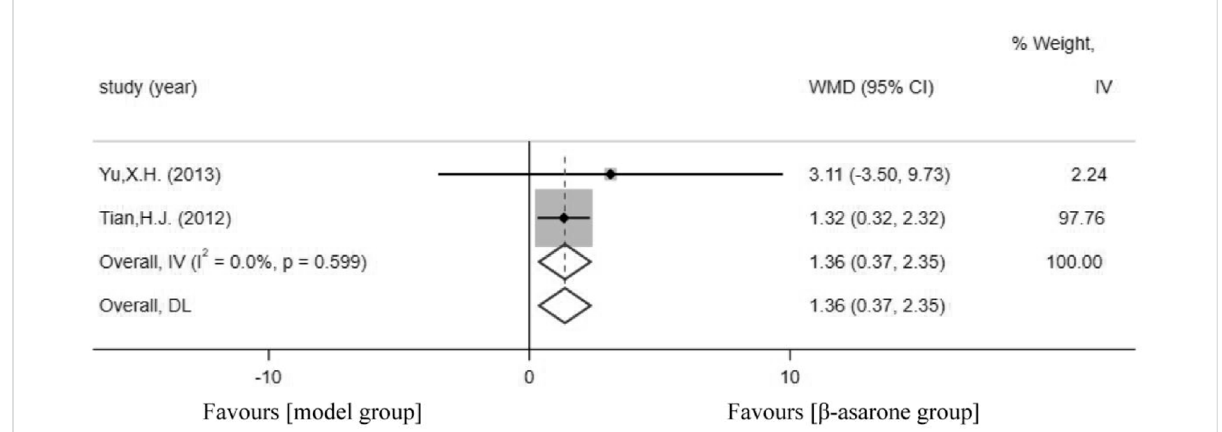
FIGURE 12 Forest plot for comparison: β -asarone group versus model group. Outcome: the times of crossing platforms.